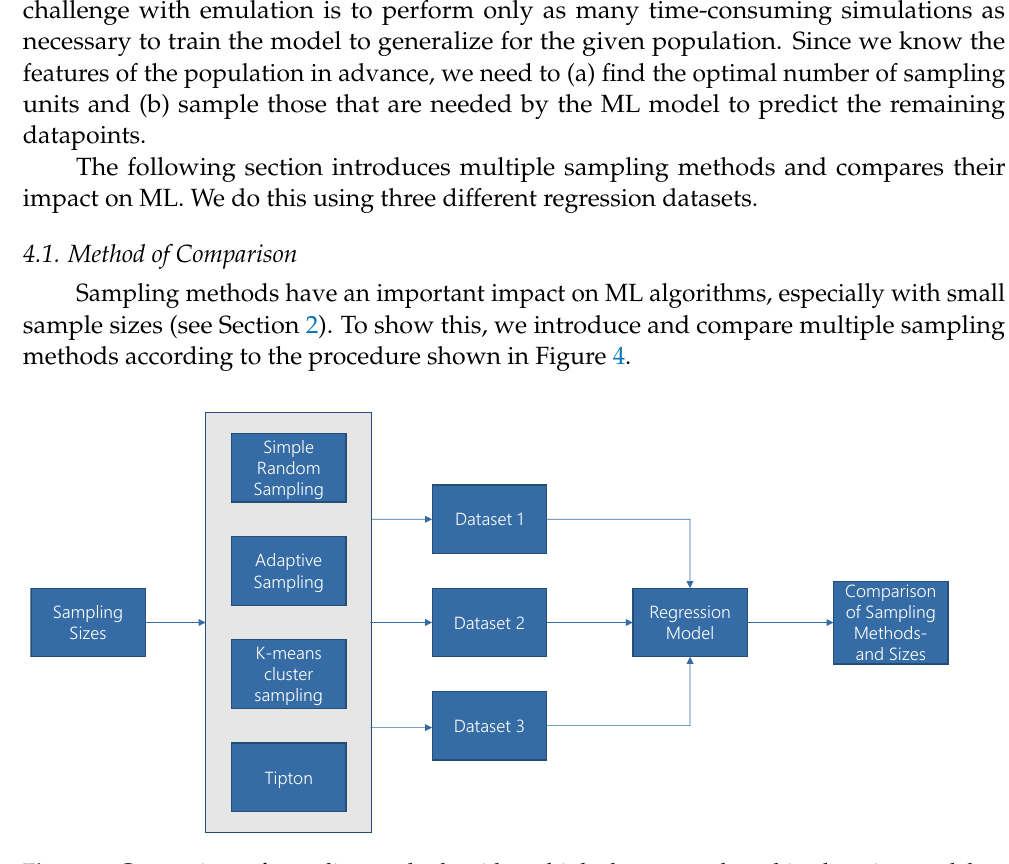
Figure 4. Comparison of sampling methods with multiple datasets and machine learning models.